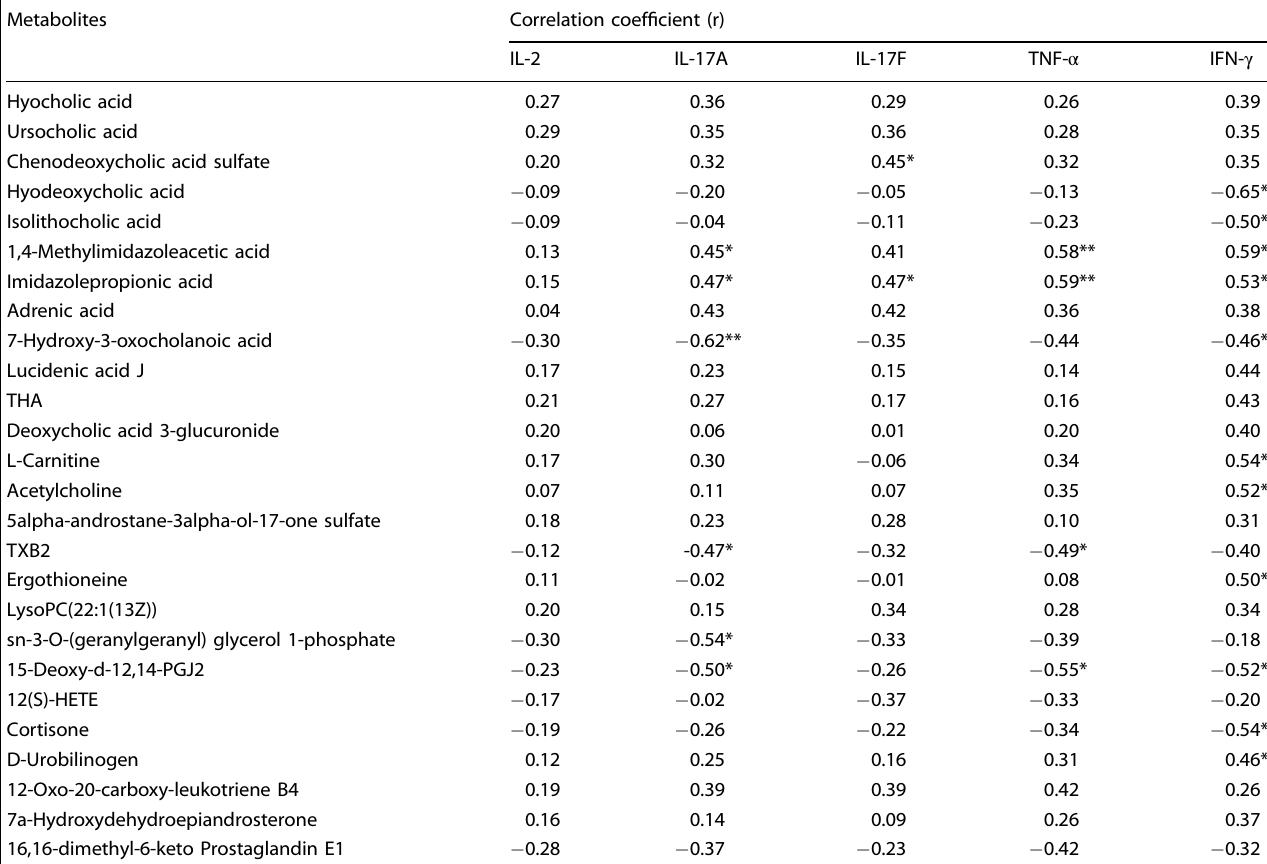
Table 3. Correlation analyses between the abnormal metabolites and in fl ammatory cytokines.